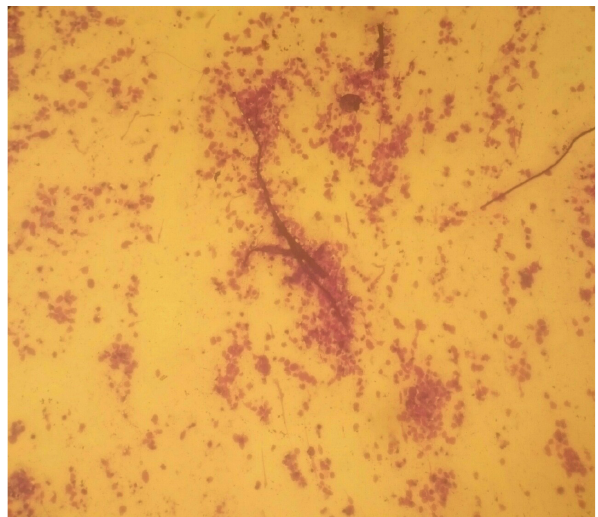
Figure 3A: Squash Smear: Oligodendroglioma showing monomorphic to mildly pleomorphic tumor cells in a glial background with thin walled capillaries.